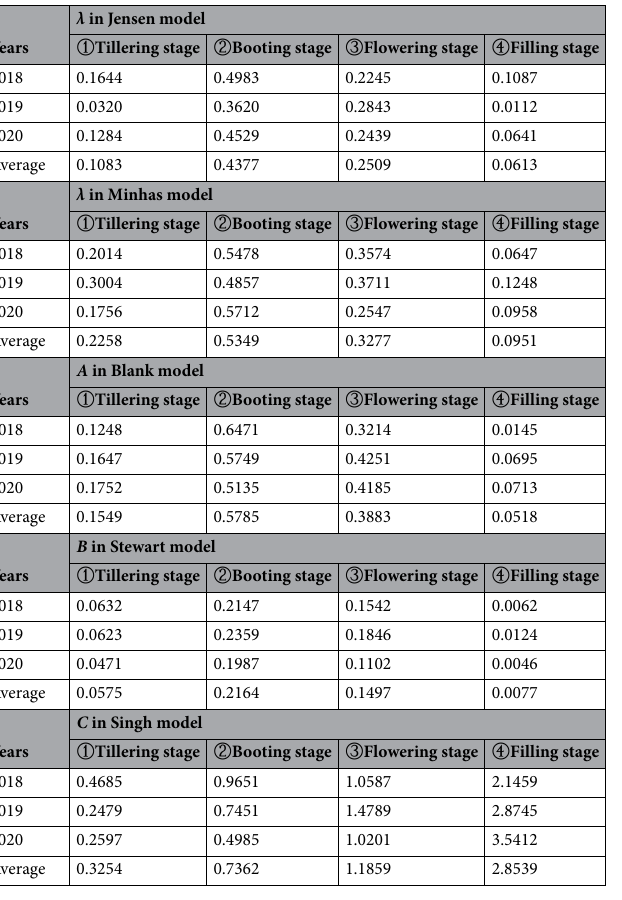
Table 7. Sensitive coefficient or sensitivity index in the water production function models. The water production function for rice is the quantitative relationship between water and rice yield. Based on previous research results, the Jensen and Minhas models, which are multiplicative models, and the Blank, Stewart, and Singh models, which are additive models, were used in the experimental design. And λi, Ai, Bi, Ci are the sensitivity coefficient or sensitivity index of crop yields to the lack of